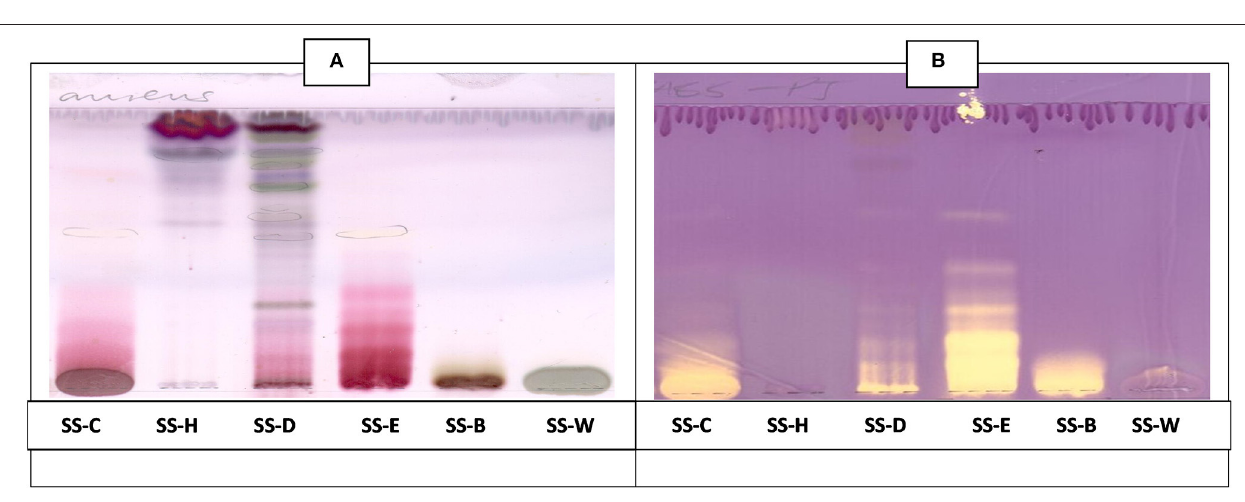
FIGURE 7 | (A) Chromatogram developed in CEF [chloroform: ethyl acetate: formic acid (5:4:1)] of S. singueana fractions sprayed with vanillin. (B) Antioxidant bioautography–TLC plate developed with CEF (5:4:1) and sprayed with DPPH. Yellowish bands indicate compounds antioxidant activity. SS-C, S. singueana crude extract; SS-H, hexane fraction; SS-D, dichloromethane fraction; SS-E, ethyl acetate fraction; SS-B, butanol fraction; SS-W, Water